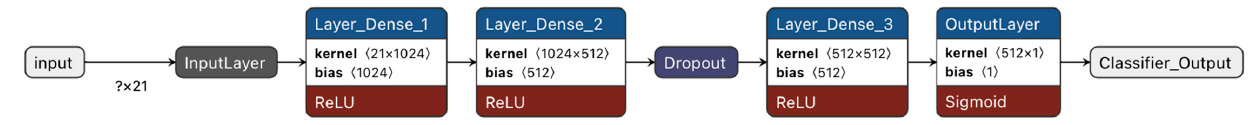
Figure 1. Flowchart of the DNN model proposed in this study.